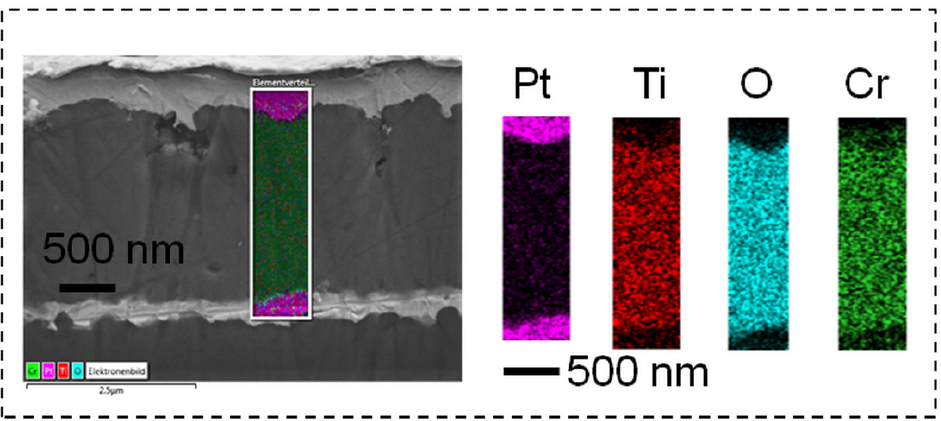
Figure 4. The color mapping of the various elements (Pt, Ti, O, and Cr), showing the Cr incorporation into the TiO 2 sensing layer.